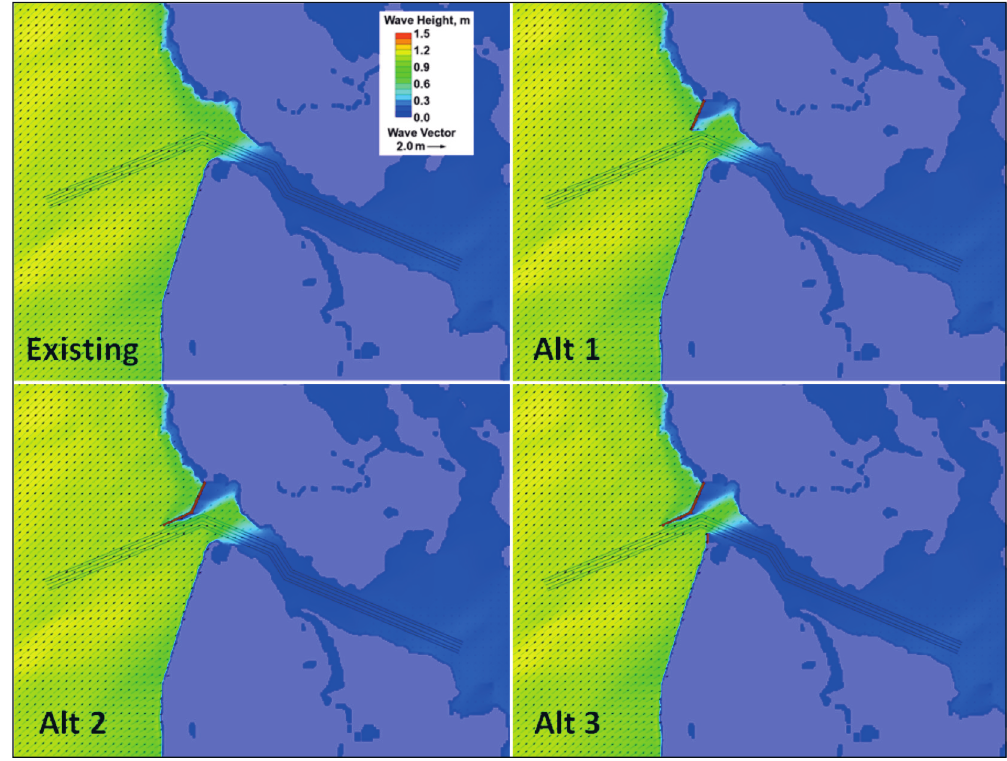
Figure 14. Example of model calculated wave heights in the west channel for the 50-year design winds from SW at 0 m water level.